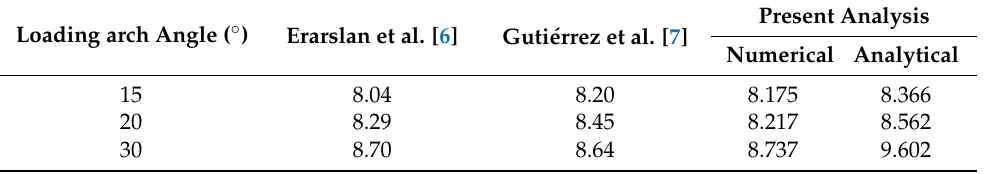
Table 1. Predicted indirect tensile strength σ t (MPa) compared to [6,7]. Loading arch Angle ( ◦